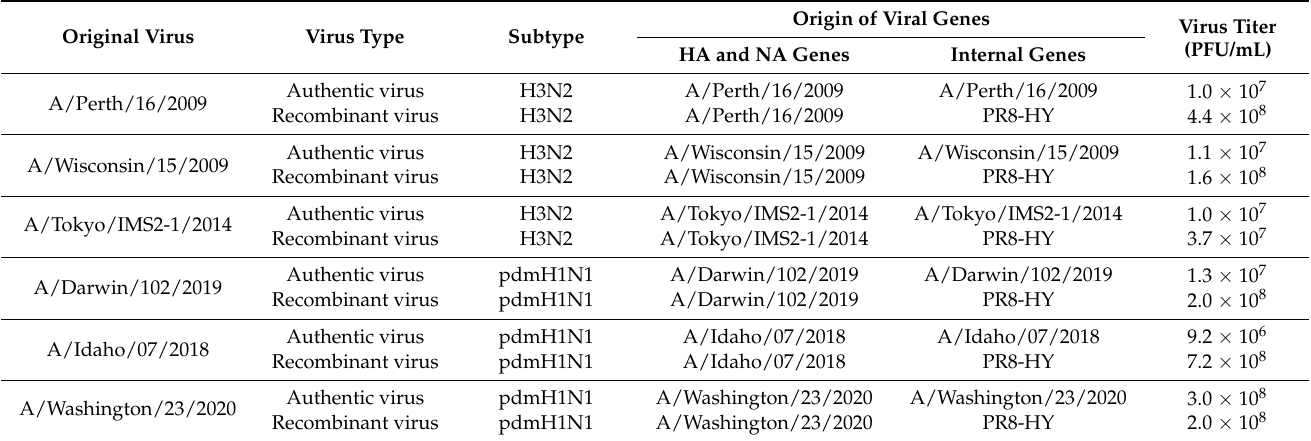
Table 1. Virus titers of authentic and PR8-HY recombinant human H3N2 and pdmH1N1